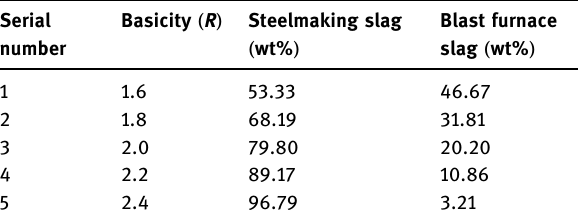
Table 5: Ratio of mixed slag to batching Serial Basicity ( R ) Steelmaking slag number